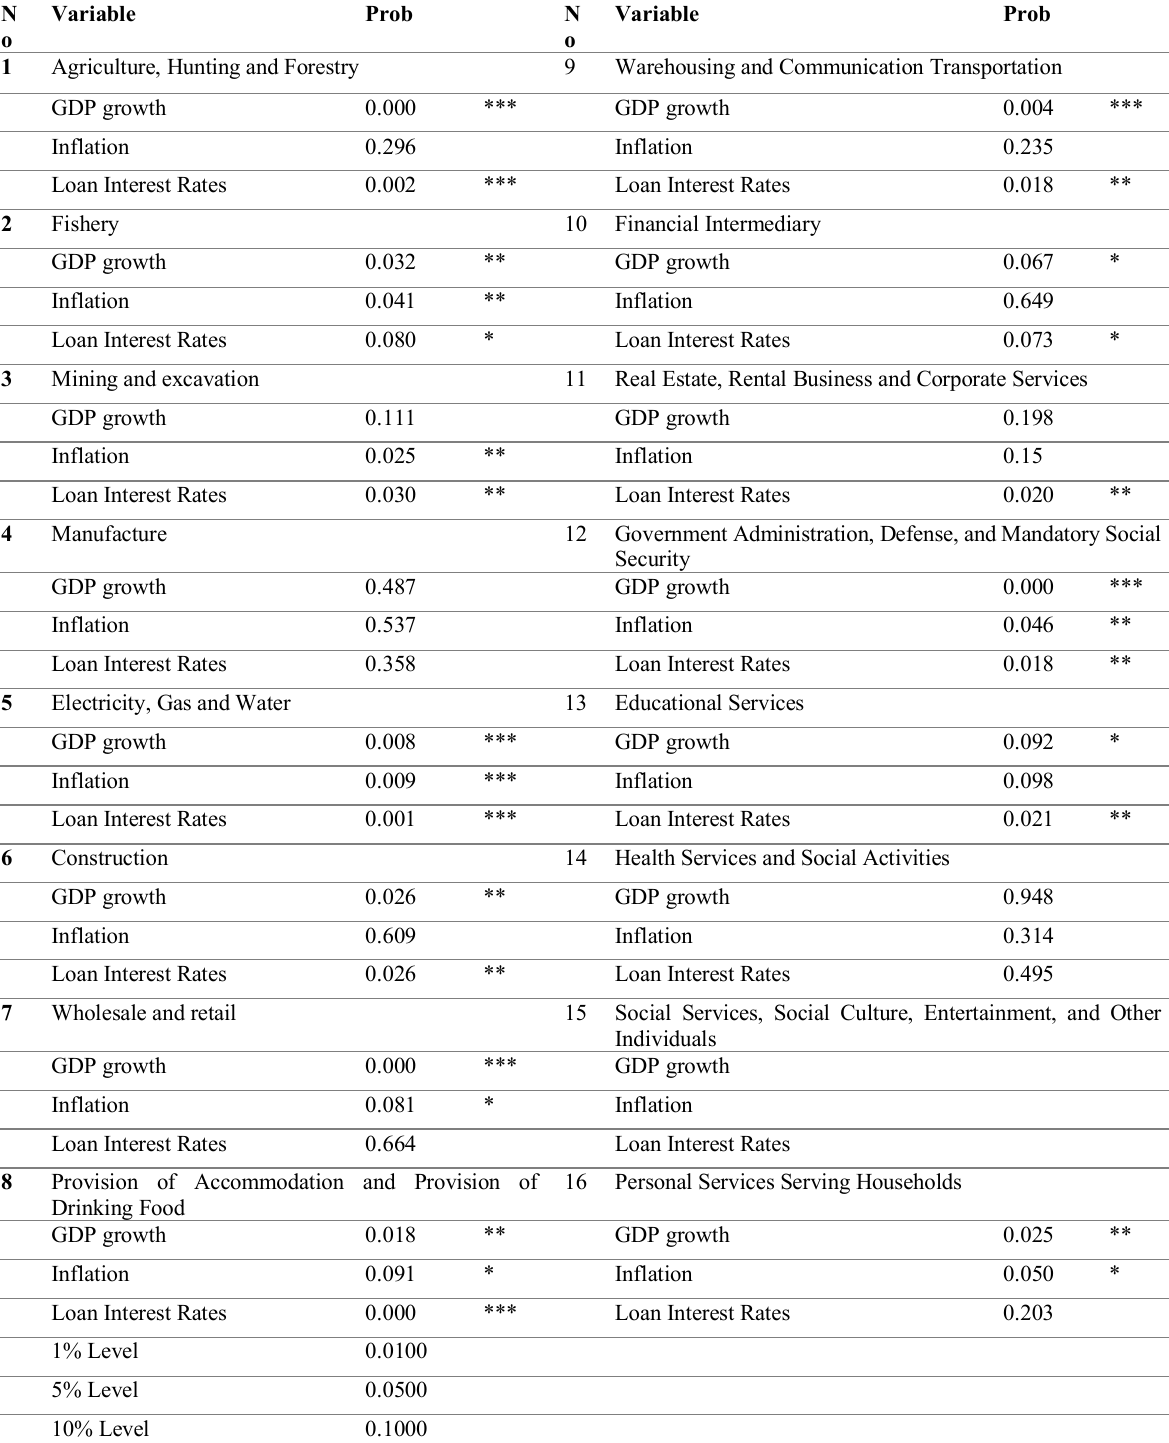
Table 4 : Level of Significance of Variables in the Short-Term